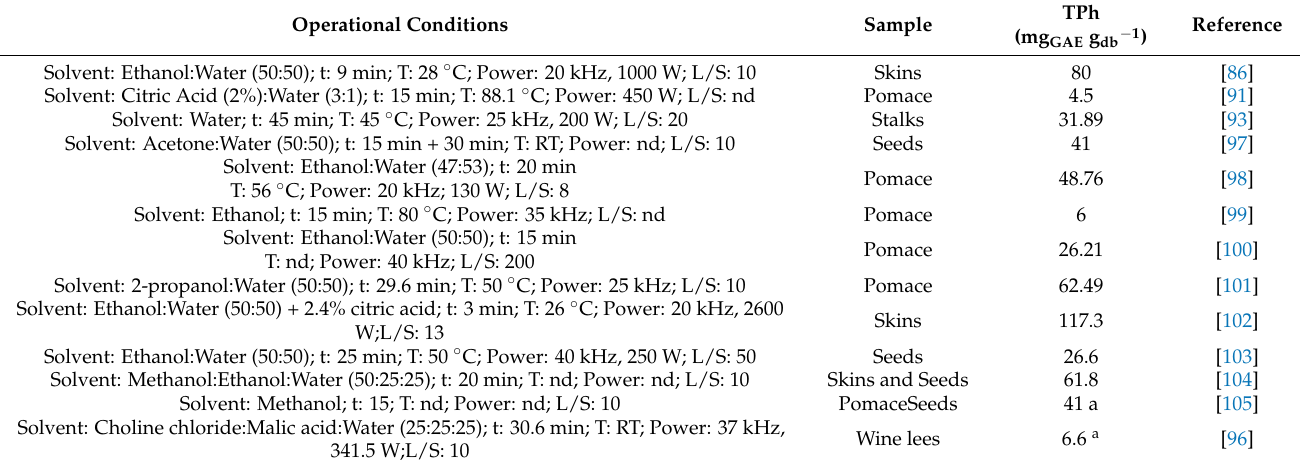
Table 7. Summary of ultrasound-assisted extraction for the recovery of phenolic compounds from solid winery